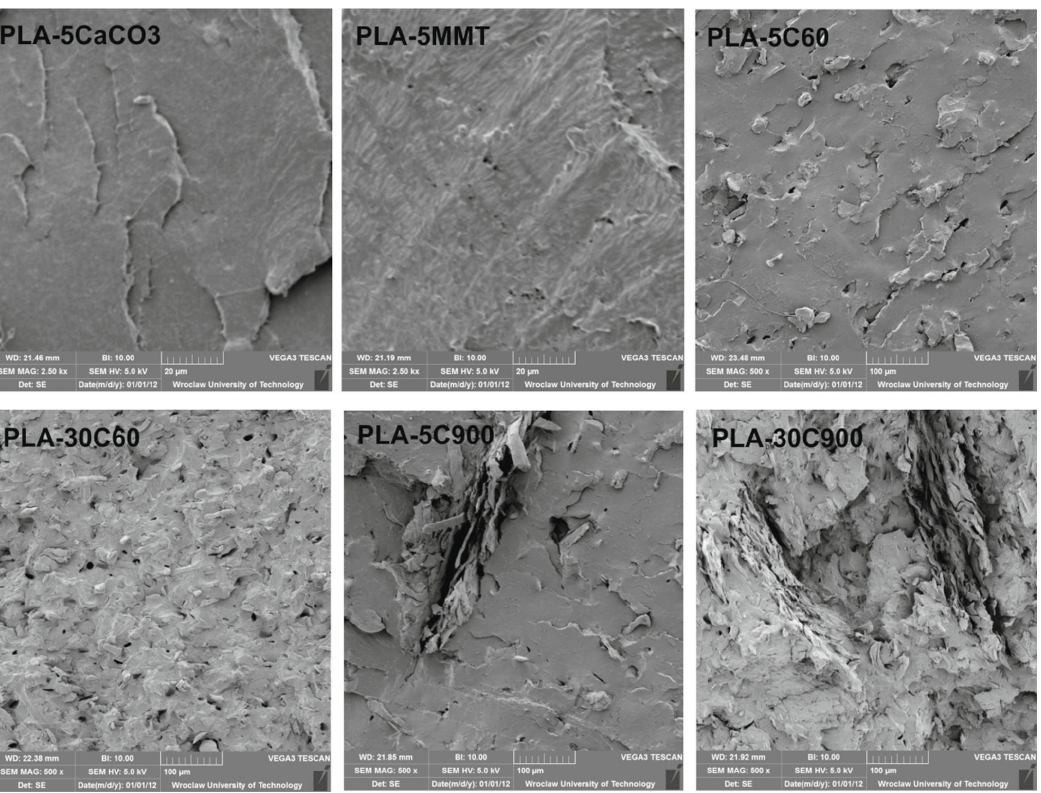
Figure 13. SEM images of PLA composites.